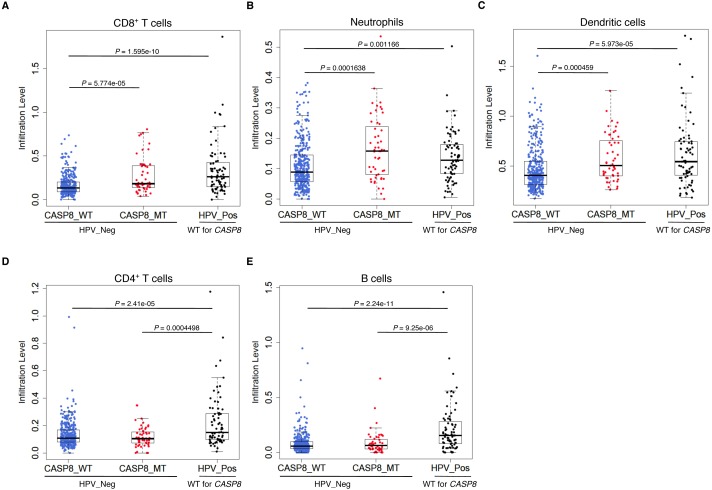
CASP8-MT HNSCs have higher numbers of certain types of infiltrating immune cells compared to CASP8-WT HNSCs.Immune cell infiltration levels in CASP8-WT (blue-filled circles), CASP8-MT (red-filled circles) (both HPV-negative), and HPV-positive (black-filled circles) HNSCs were compared using the immune cell infiltration data available at TIMER. Boxplots showing the levels of CD8+ T cells, neutrophils, and dendritic cells (A–C), as well as CD4+ T cells and B cells (D, E) in the three HNSC subsets are displayed. Significance testing was performed using the unpaired two-sided Wilcoxon test. All comparisons with P-value < 0.005 were considered significant and are indicated in the plots.